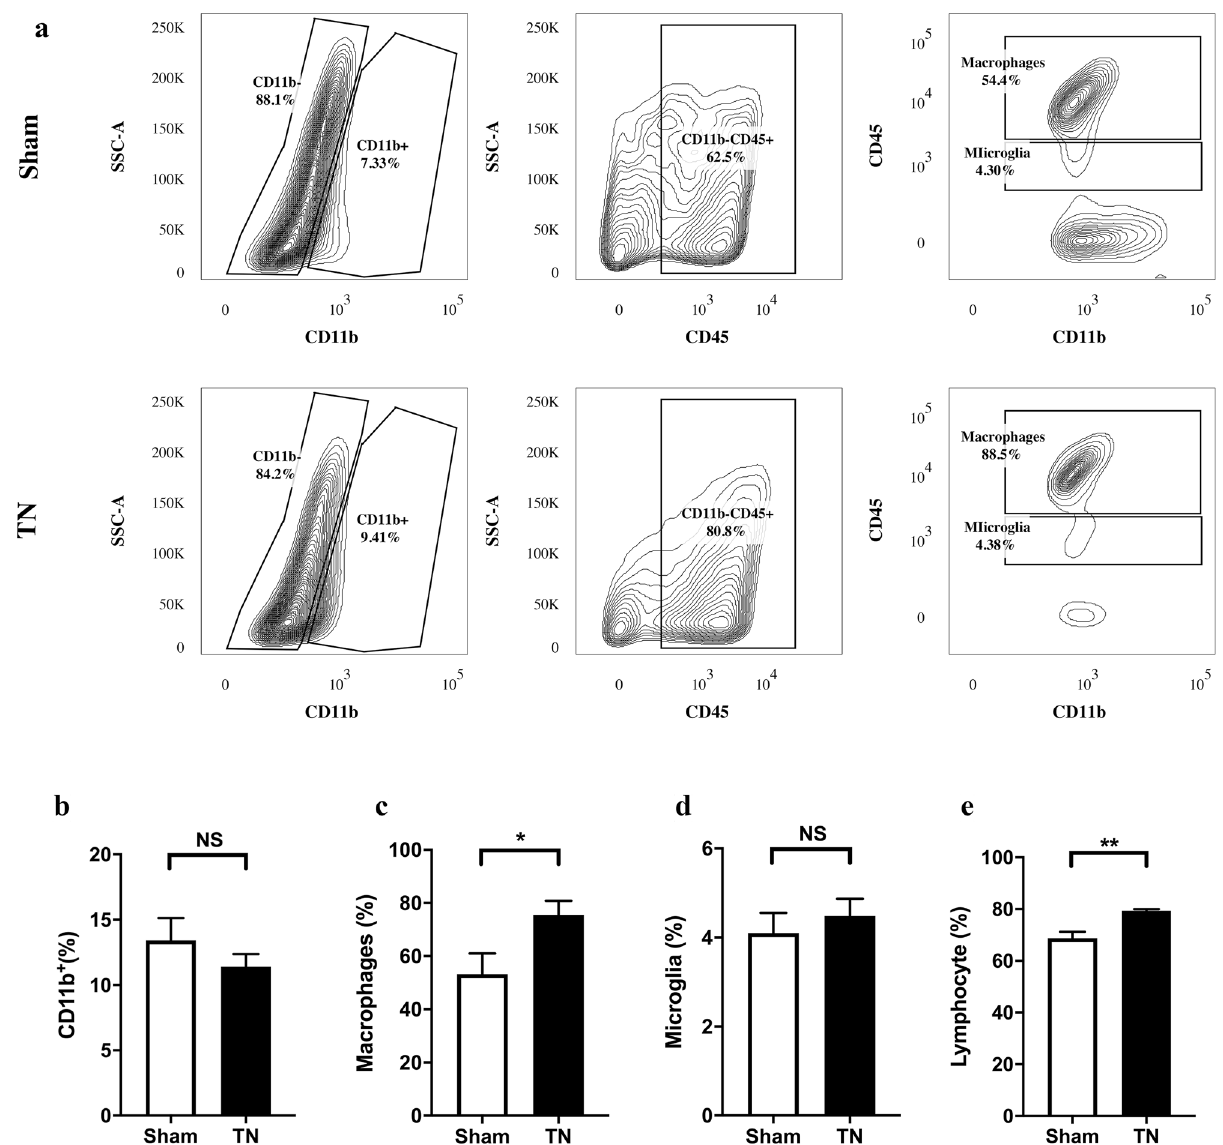
Figure 8. Numbers and proportions of immune-related cells in the TREZ and TG. ( a ) Flow contour plot of immune-related cells in the TREZ and TG in the two groups of rats. ( b ) The ratios of CD11b + cells in the TREZ and TG of the TN group were lower than those of the sham group. ( c – e ) The ratios of macrophages (CD45 high CD11b + ) and lymphocytes (CD45 + CD11b − ) in the TREZ and TG of the TN group were higher than those in the sham group. The difference in the proportions and numbers of microglia (CD45 low CD11b + ) between the two groups was not statistically significant. * p < 0.05, ** p < 0.01, ns: not significant, as determined by two-tailed Student’s t-test. SSC side